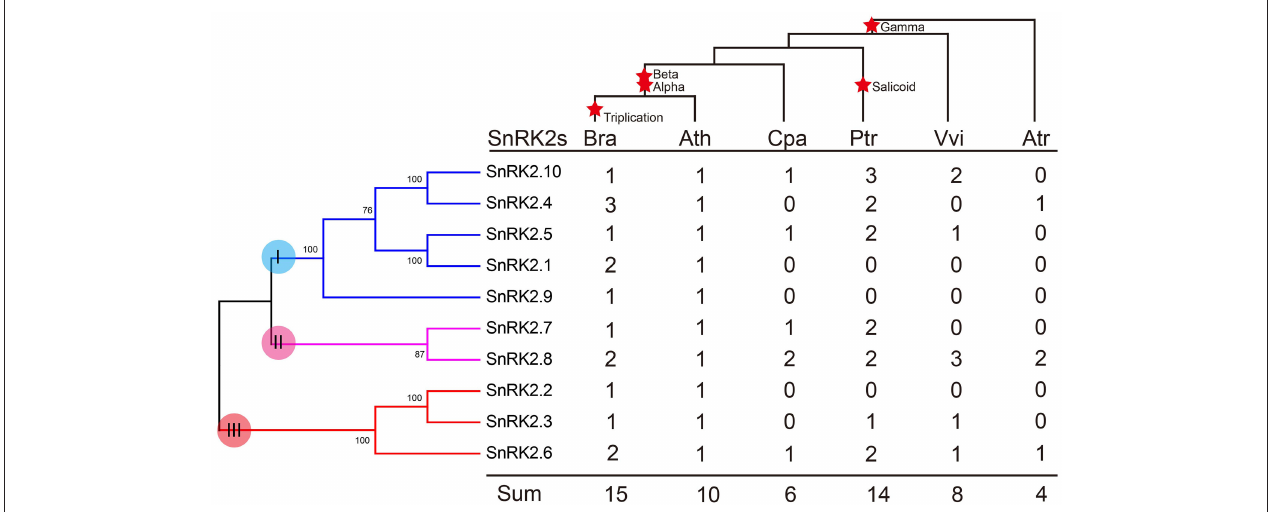
FIGURE 2 | Copy number variation in the SnRK2 family in plants. The phylogenetic tree of SnRK2 genes is shown on the left, and the species tree is shown at the top. The α , β , γ , and salicoid duplications and the Brassica-specific triplication are indicated on the branches of the trees according to the Plant Genome Duplication Database. Numbers are copy numbers of each gene in A. trichopoda (Atr), V. vinifera (Vvi), P. trichocarpa (Ptr), C. papaya (Cpa), B. rapa (Bra), and A. thaliana